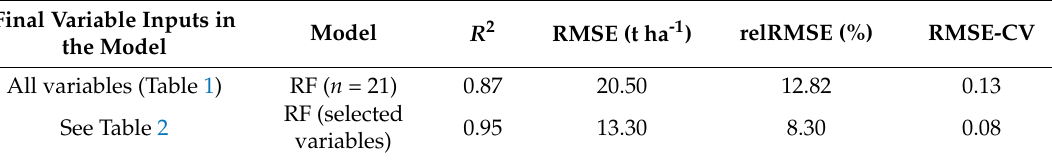
Table 5. Biomass prediction results based on the RF.